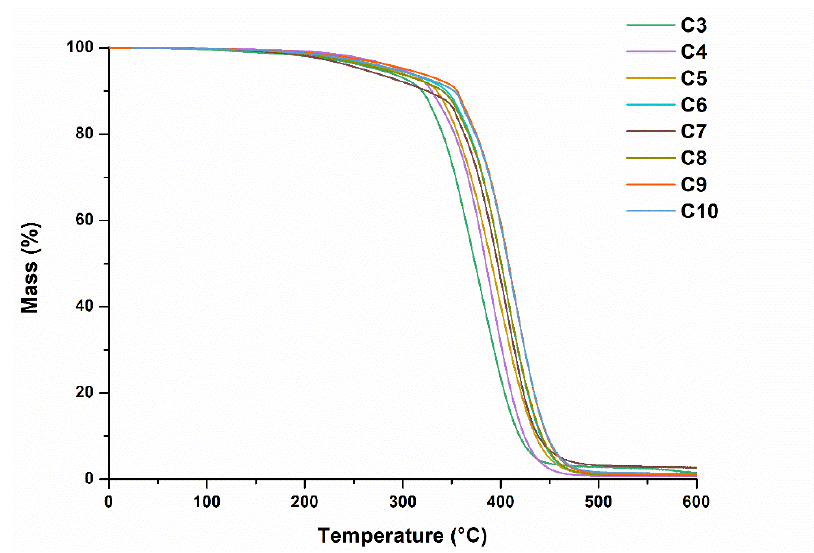
Figure 6. Thermogravimetric curves of photopolymers C3 – C10.